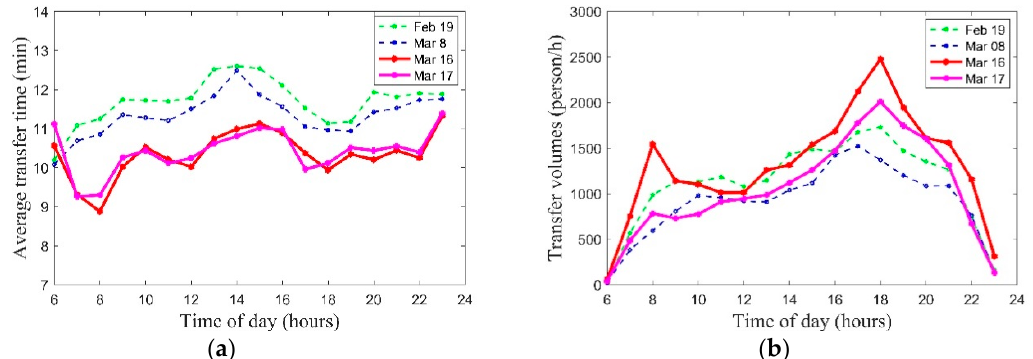
Figure 2. Transfers distribution on festivals and weekends. ( a ) Transfer time distribution. ( b ) Transfer volume distribution.